Question: In a single sentence, describe what this figure presents.
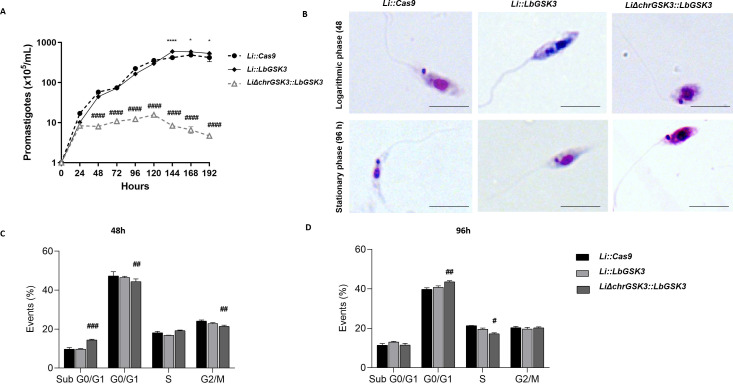
Answer: GSK-3s knockdown parasites exhibit reduced growth in culture and altered morphology compared to Li::Cas9 parasites. ( A ) Growth curves of Li::Cas9 , Li::LbGSK3 , and LiΔchrGSK3::LbGSK3 promastigotes. Parasites were seeded at 1 × 10 5 /mL and cultivated for 8 days, with cell densities determined daily. Data represent averages of three independent experiments performed in triplicate. Curves were statistically analyzed using two-way analysis of variance with Bonferroni post hoc tests. ( B ) Optical microscopy of Li::Cas9 , Li::LbGSK3 , and LiΔchrGSK3::LbGSK3 promastigotes stained with Giemsa 48 h and 96 h post-passage. Images were acquired using an Axio Observer A1 fluorescence microscope (Zeiss). Scale bars: 5 μm. Cell cycle analysis of Li::Cas9 , Li::LbGSK3 , and LiΔchrGSK3::LbGSK3 at 48 ( C ) and 96 ( D ) h of growth, respectively. The parasites were stained with propidium iodide and evaluated by flow cytometry. Data represent the mean ± standard deviation of three independent experiments performed in triplicates. We used Li::Cas9 as the control. * P < 0.05, ** P < 0.01, *** P < 0.001, and **** P < 0.0001 for Li::Cas9 vs. Li::LbGSK3 ; # P < 0.05, ## P < 0.01, ### P < 0.001, #### P < 0.0001 for Li::Cas9 vs. LiΔchrGSK3::LbGSK3 .